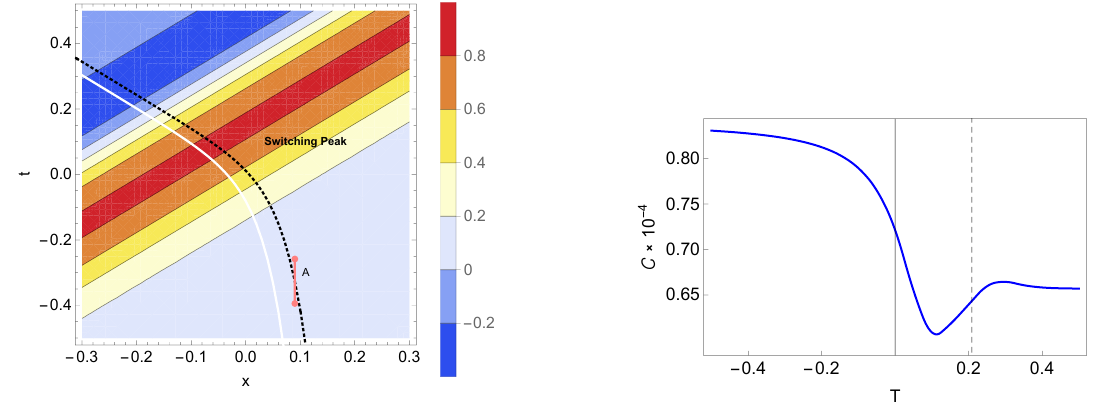
Figure 5 . Insensitivity of concurrence to energy density sign change. In the mirror spacetime, the energy density T tt = T uu depends only on u and is constant on these null lines. This is clearly re(cid:13)ected on the top plot, whose colour density indicates the local energy density in the t=x plane. For the (cid:24) = 0 : 99 mirror (white trajectory) used here, the energy density changes from positive to negative at some intermediate u . To investigate the impact of the change in sign on entanglement harvesting, we consider a series of static detector pairs, each switching on at di(cid:11)erent u values. The red bar on the top (cid:12)gure shows an example of the spacetime support of the switching function of detector A . The detector settings used here are (cid:1) (cid:28) = (cid:25)=(cid:17) = 0 : 136 ; (cid:1) x = 0 : 05 ; (cid:10) = 50 ; (cid:20) = and d A = 0 : 04 (black dashed). With this d A setting, detector A passes from positive to negative energy density at T (cid:25) 0 : 2095. The concurrence C against T plot is shown on the bottom. We see that the concurrence varies smoothly across T (cid:25) 0 : 2095, indicating that the concurrence is not directly a(cid:11)ected by a change in the sign of energy